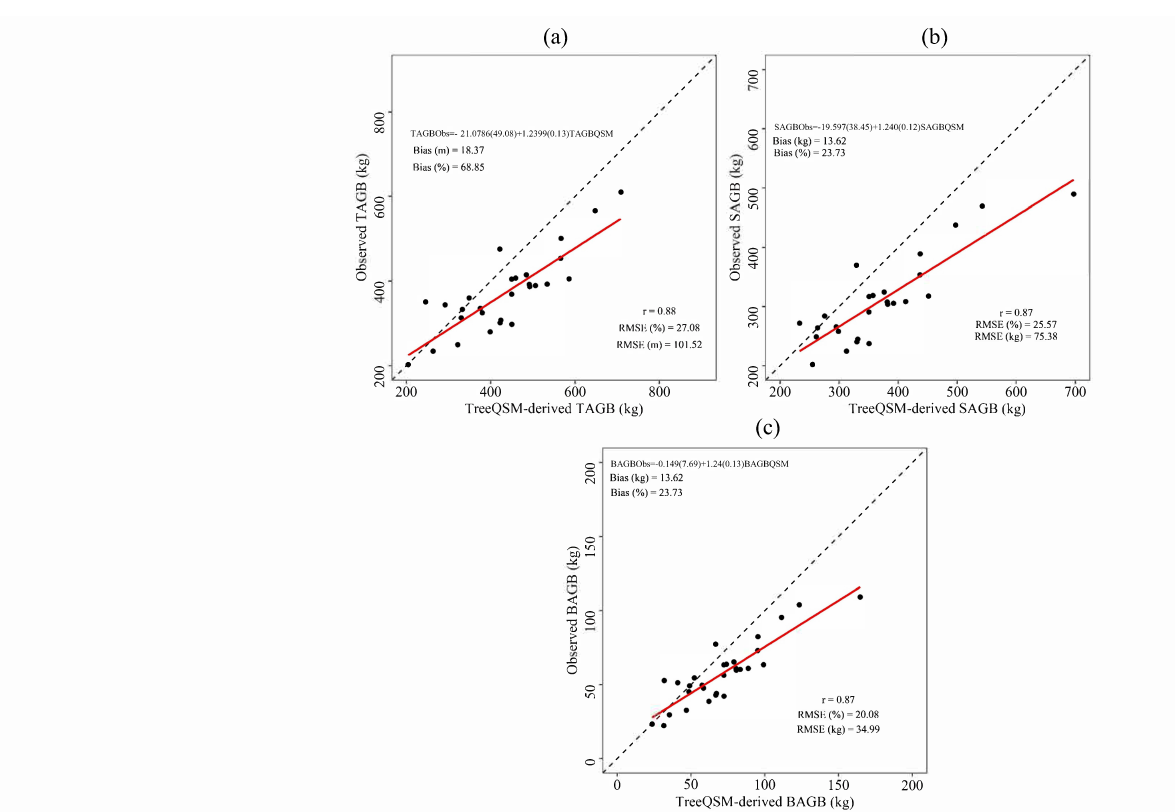
Figure 7. Relationship between field-observed and QSM-derived biomass estimates: ( a ) Individual tree TAGB (kg); ( b ) Individual tree SAGB (kg); ( c ) Individual tree BAGB